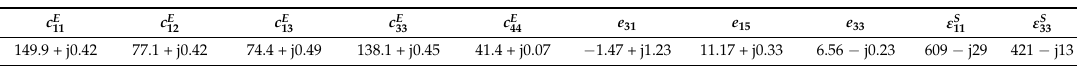
Table 2. Parameters from the iterative analysis of the impedance of thin disks and plates, thickness-poled. Elastic constants are in GPa, piezoelectric constants in C/m 2 .